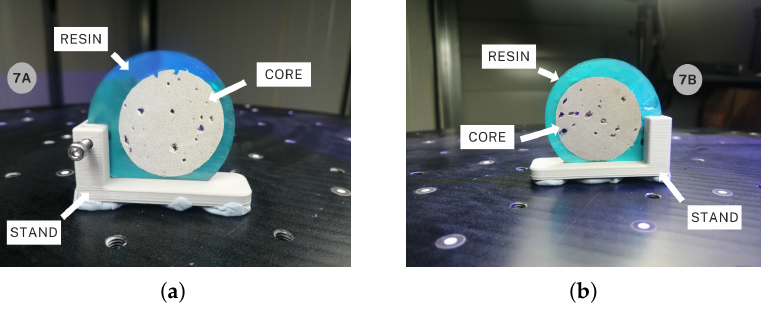
Figure 5. Slice no. 7 placed in the stand on the rotating table at the front ( a ) and rear ( b )